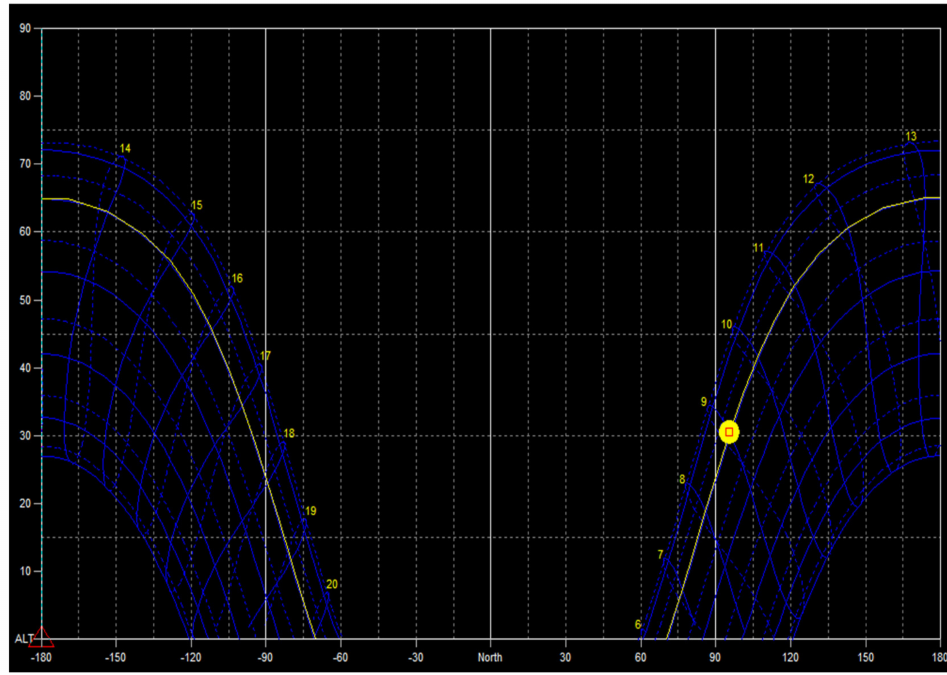
Figure 11. Solar orbit orthography and sphere shadow diagram of the planned area.